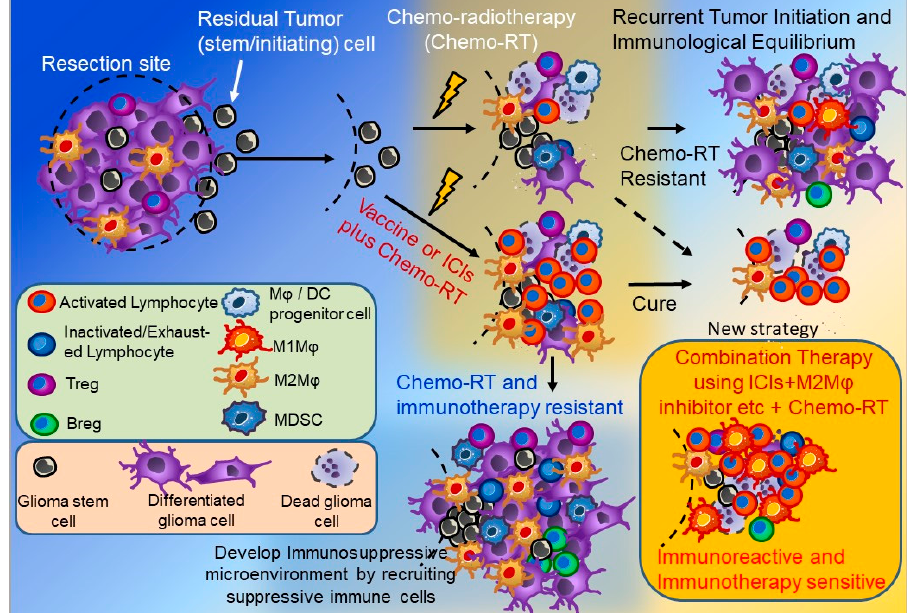
Figure 3. Therapeutic strategies for controlling immunosuppressive cells and ICI combination therapy for glioma. The immunosuppressive cell number increases after standard therapy +/ − ICIs in the glioma microenvironment and the tumor becomes ‘cold’ (blue area). ICIs plus anti-immunosuppressive cell combination therapy causes the tumor to become ‘hot’ (orange area).